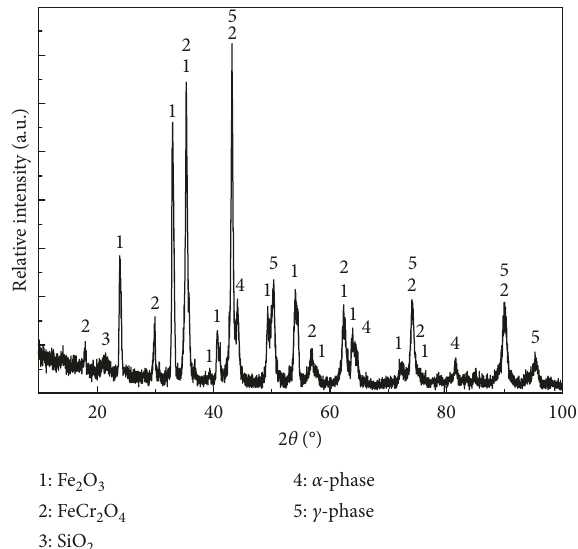
Figure 1: XRD pattern of the 2205 matrix and the surface oxide scale.